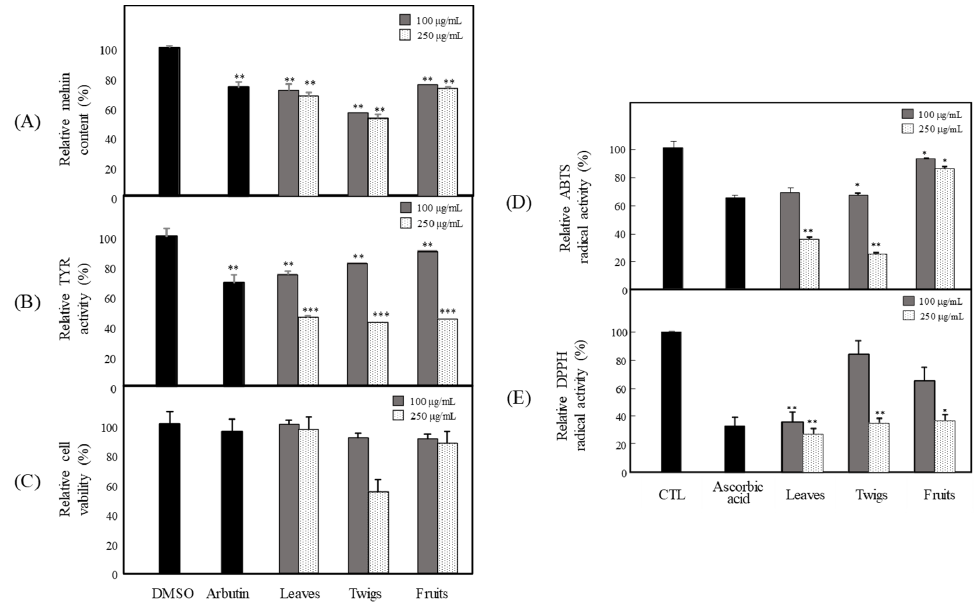
Figure 1. Anti-melanogenesis and antioxidant effects of P. angustifolia leaves (PAL), twigs (PAT) and fruits (PAF) extracts. ( A ) Melanin content, ( B ) tyrosinase (TYR) activity ( C ) cytotoxicity in B16F10. ( D ) ABTS and ( E ) DPPH radical-scavenging activities. The data are expressed as the mean ± SD ( n = 3) of three individual experiments. * p < 0.05, ** p < 0.01 and *** p < 0.001, compared with control.